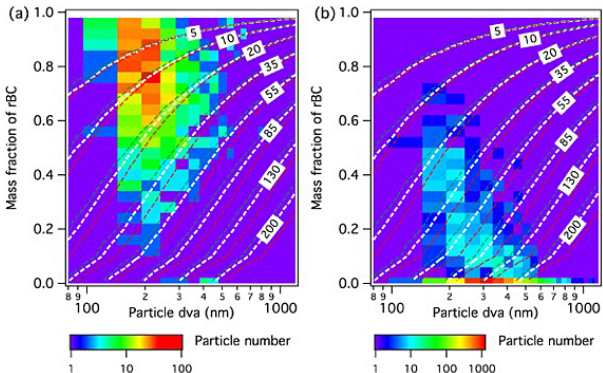
Figure 4. Two-dimensional histograms (mf rBC vs. particle aerody- namic diameter) of rBC-rich (a) and HOA-rich (b) particle classes. The colour scale represents the number of particles in each parti- cle class. The dashed lines represent the physical thickness (nm) of organic coating on rBC-containing particles determined by mod- elling the particles as a core-shell structure. Note that the d va of model outputs are calculated by the physical diameter ( d p ) and the d p ρ p , where ρ p is the linear density ( ρ p ) of particles (i.e., d va = · combination of mass-weighted HOA and rBC density). To examine the potential effect of fractal structure of ambient rBC particles on predicted coating thickness, the effective density of rBC was varied (green: 0.3gcm − 3 ; white: 0.8gcm − 3 ; red: 1.3gcm − 3 ). Figure 5. Time series of (a) ensemble organic aerosol and (b) re- fractory black carbon mass loadings during the roadside study. Pos- itive matrix factorization (PMF) results for ensemble data (c–f) : (c) regionally sourced rBC mixed with oxygenated organic aerosol, (d) biomass-burning organic aerosol mixed with rBC, and traffic- related rBC in an rBC-rich and HOA-rich factor (e) and (f) . Mass spectra of all PMF factors are shown in Fig.